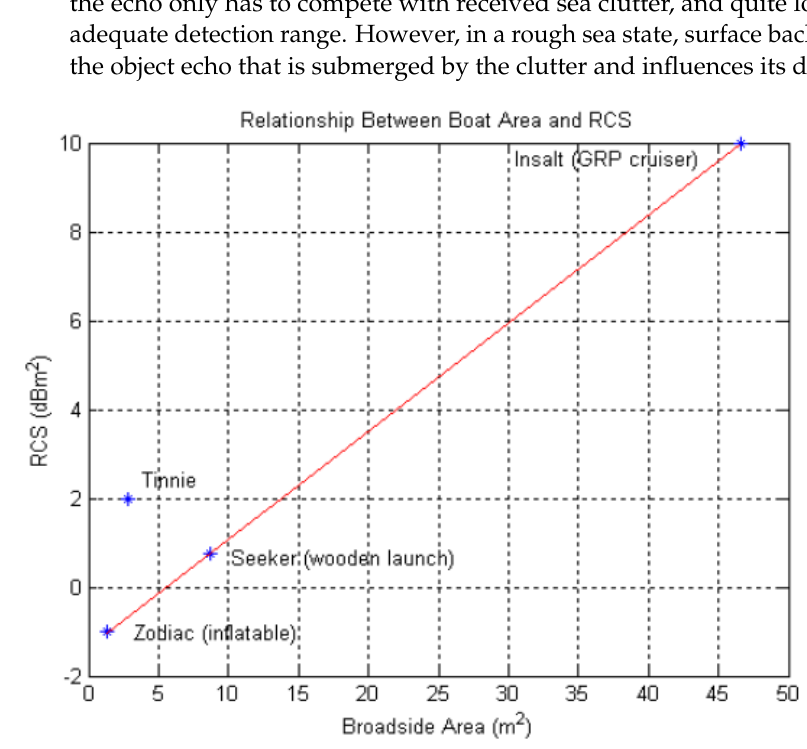
Figure 9. Relationship between the boat projected area and the median RCS [50].